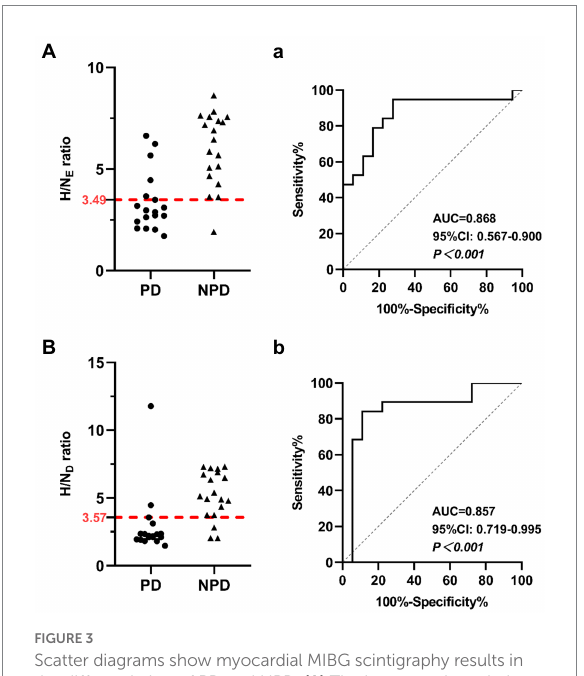
FIGURE 3 Scatter diagrams show myocardial MIBG scintigraphy results in the differentiation of PD and NPD. (A) The heart uptake ratio in early images. (B) The heart uptake ratio in delayed images. The red dotted line indicates a cutoff value that yields the most appropriate sensitivity and specificity. Receiver Operating Characteristic (ROC) analysis showing sensitivity and specificity of the heart uptake ratio in early images (a) and the delayed images (b) used to differentiate patients between PD and